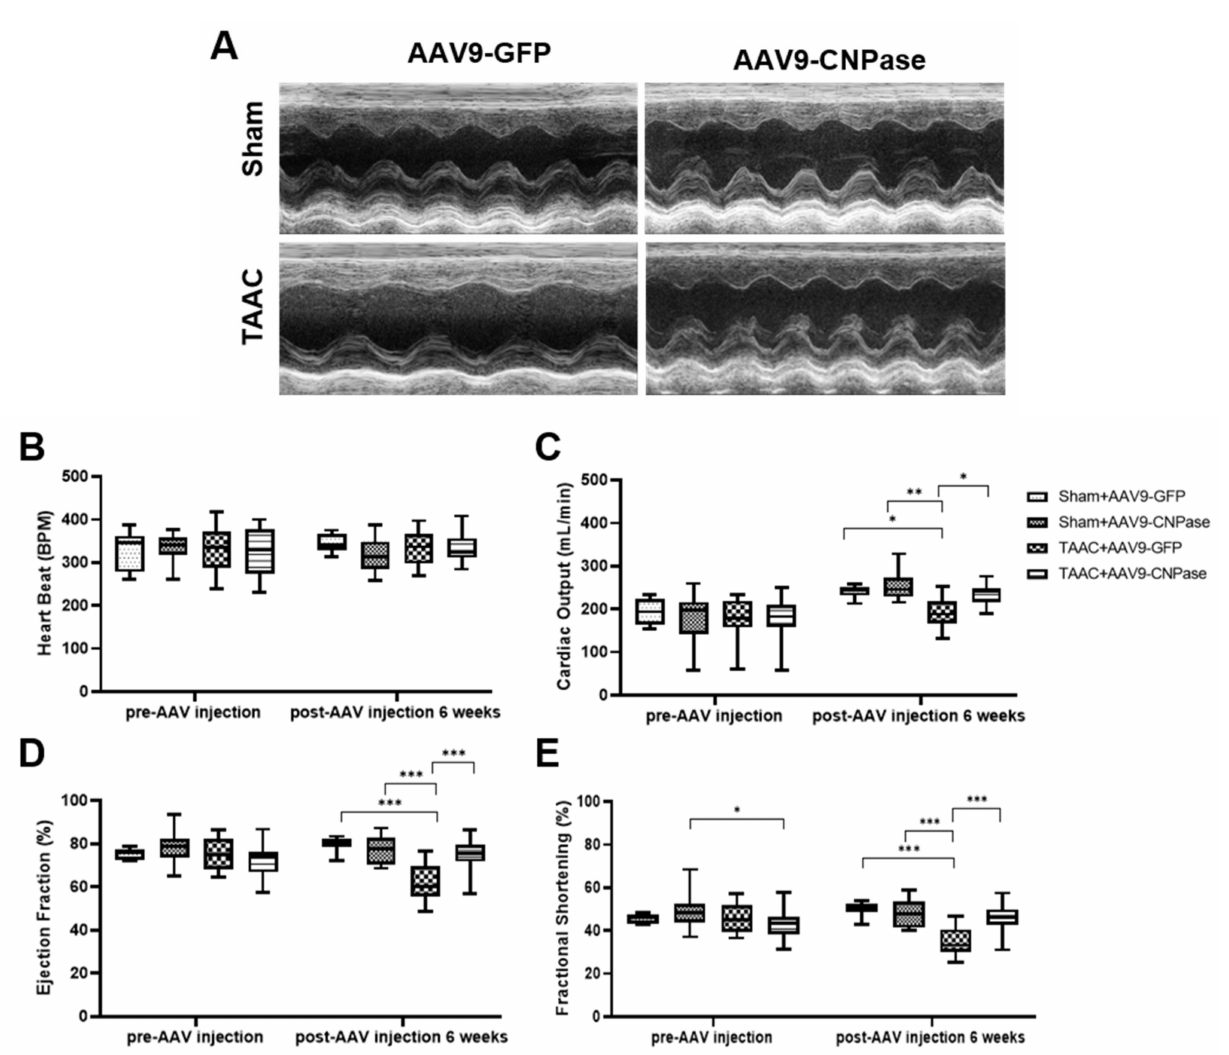
Figure 3. Myocardial CNPase delivery protects the heart from cardiac hypertrophy and dysfunction. ( A ) Representative echocardiography images of left ventricles. ( B – E ) The therapeutic effects of CNPase on heart rate, left ventricular ejection fraction, fraction shortening, cardiac output. The pressure overload-induced heart hypertrophy was carried out by transverse abdominal aorta constriction (TAAC) surgery. The AAV9-CNPase vectors (1 × 10 12 genome copies) were delivered into the left ventricular myocardium guided by echocardiography. n = 8 in the sham group, n = 14–16 in the TAAC group. One-way ANOVA, Tukey’s multiple comparisons test, *, p < 0.05; **, p < 0.005; ***, p <